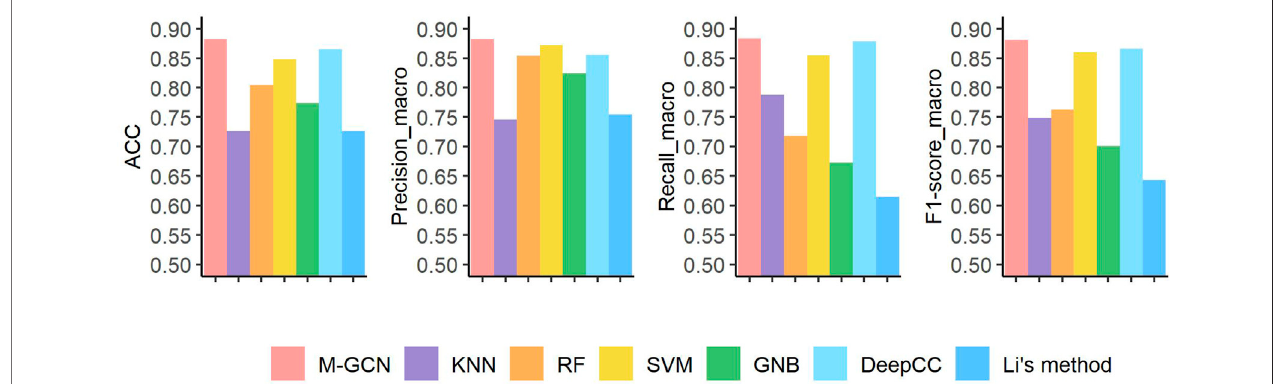
FIGURE 4 | Prediction performance under four evaluation metrics of seven methods in the STAD dataset. Pink bar represents the fi nal performance of M-GCN; purple bar, orange bar, yellow bar, and green bar refer to the performance of KNN, RF, SVM, and GNB, respectively. Light blue bar is for the performance of DeepCC, and dark blue bar is for the performance of Li ’ s method.